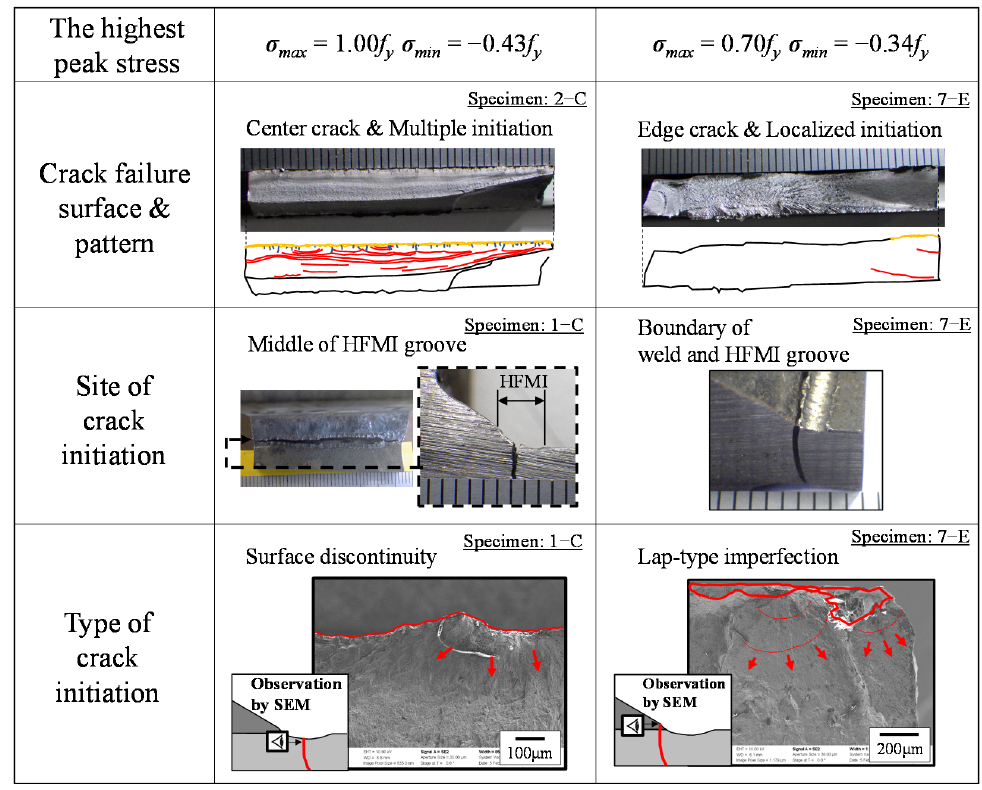
Figure 8. Observation results of fatigue crack initiation sites under different high peak stresses in the HFMI